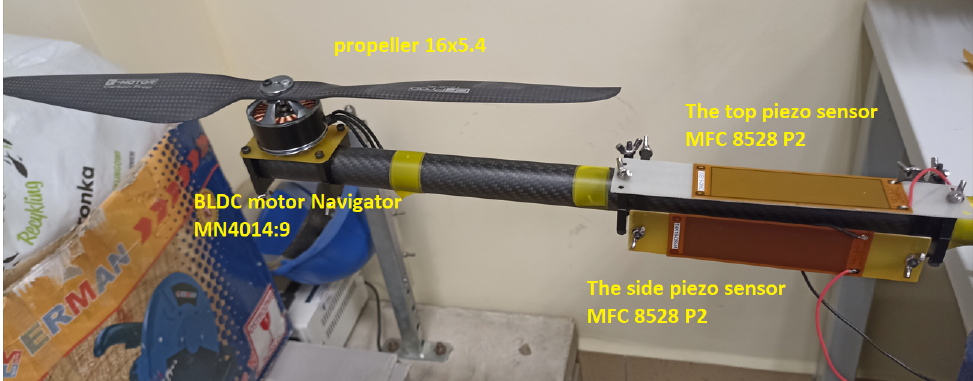
Figure 10. BLDC based drive unit with